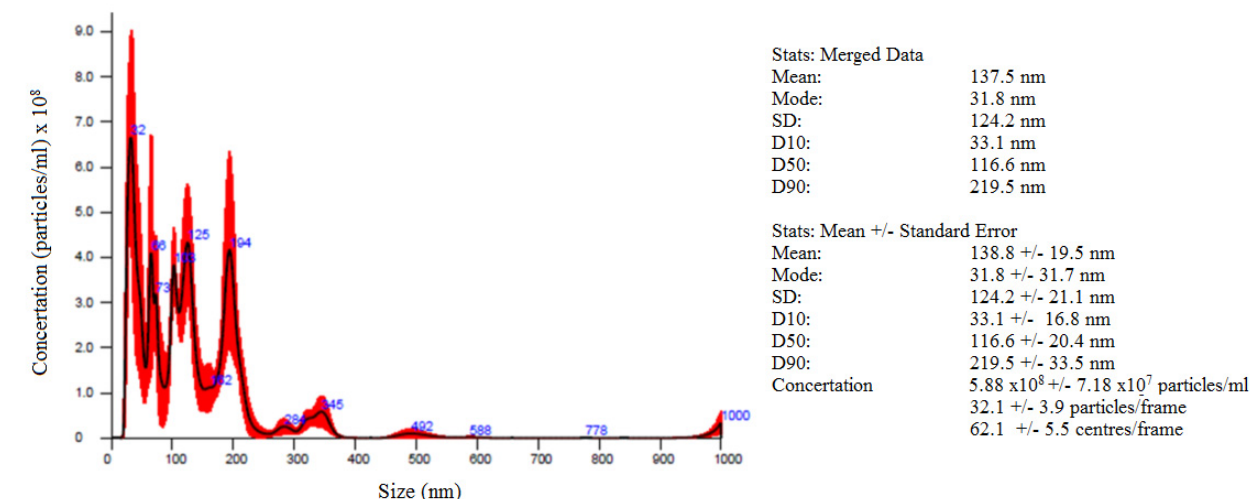
Figure 1. Nanobubbles concentration versus size.